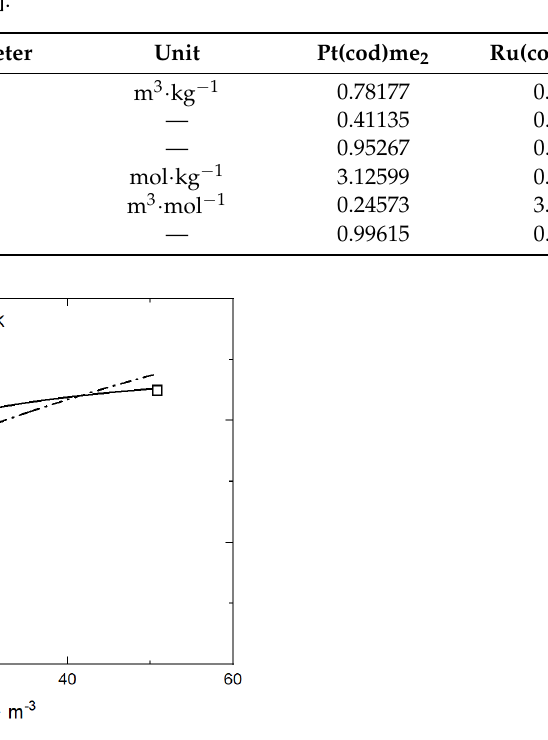
Figure A19. Uptake of different precursors on CA22 at 27.6/27.7 MPa and 353 K; experimental data taken from [37,63].